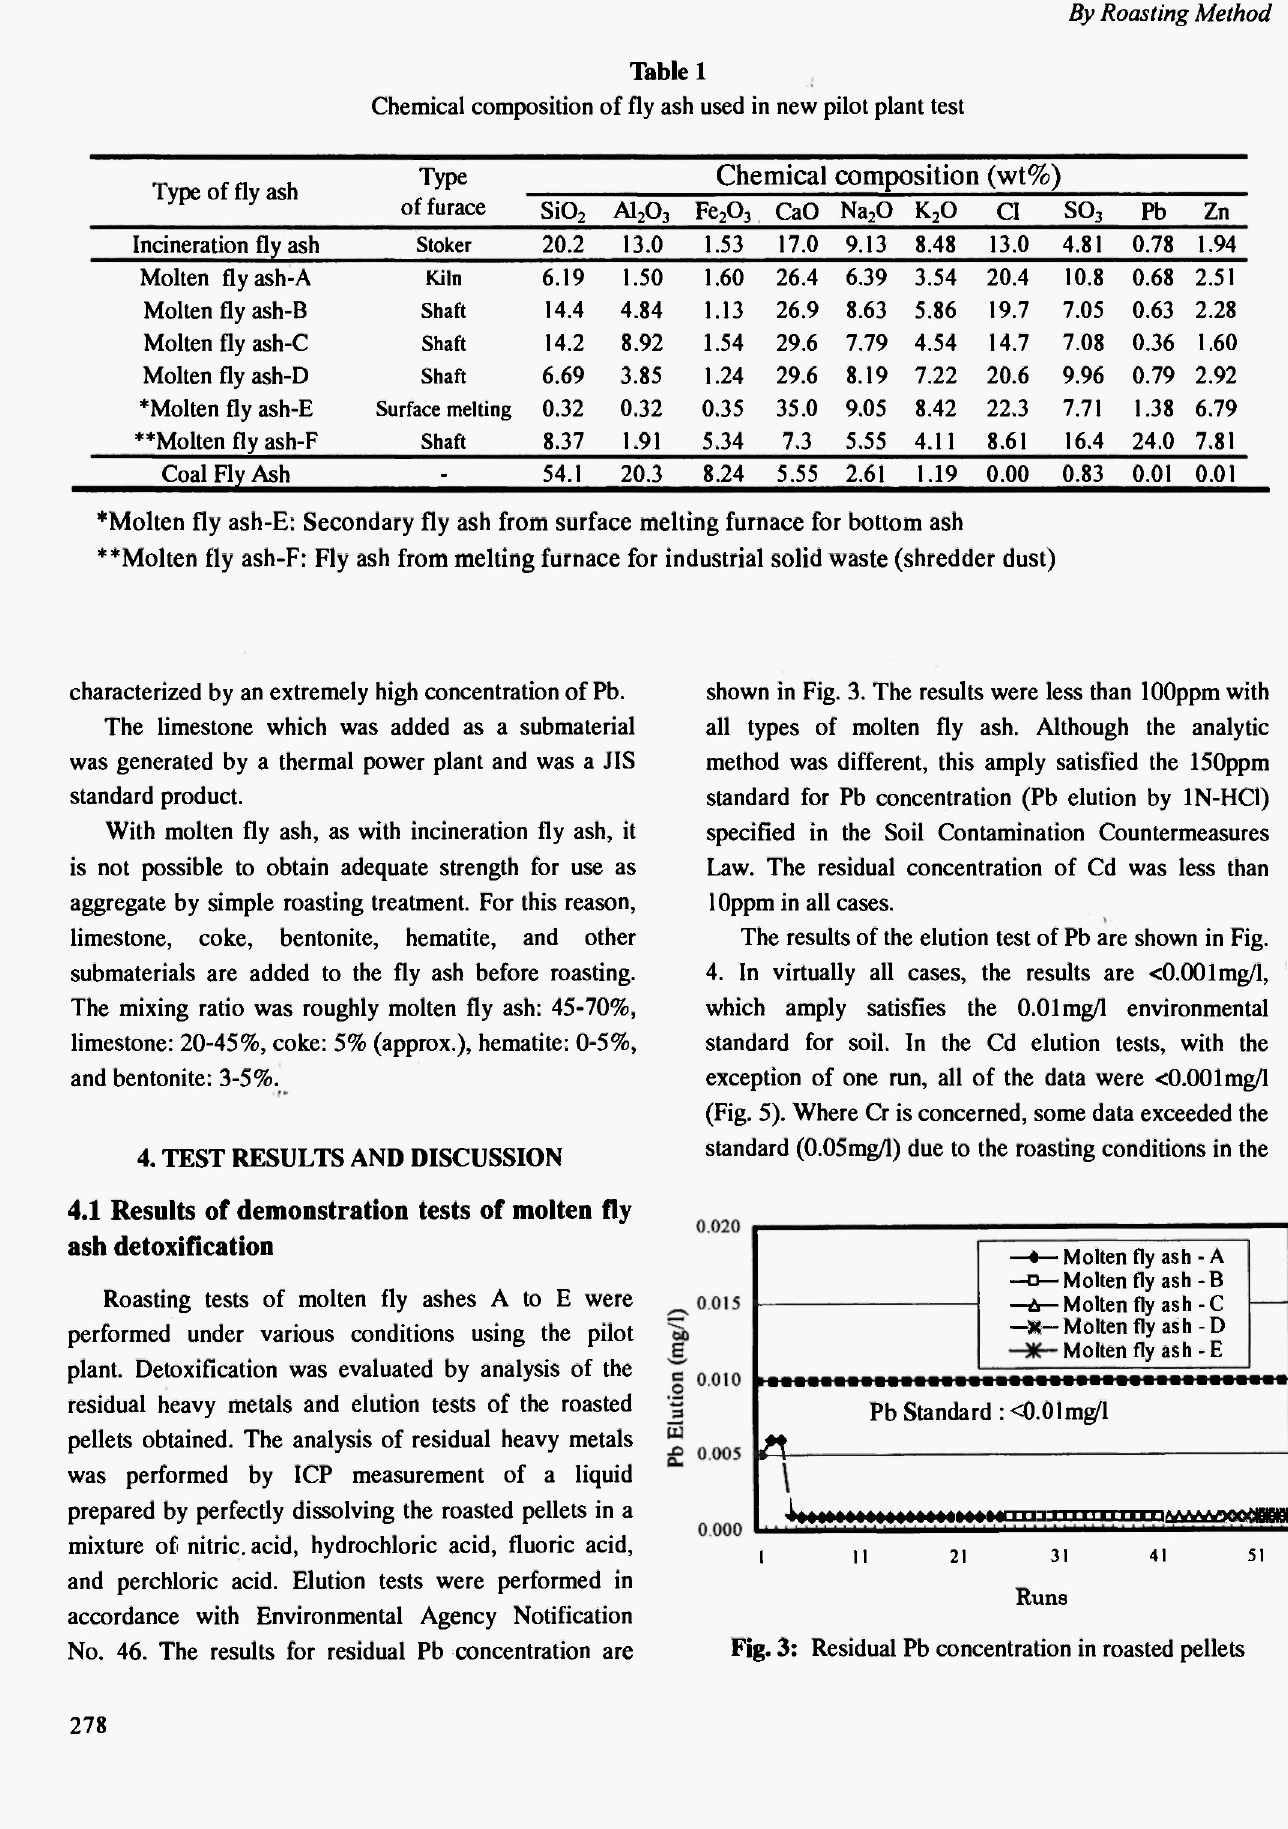
Fig. 3: Residual Pb concentration in roasted